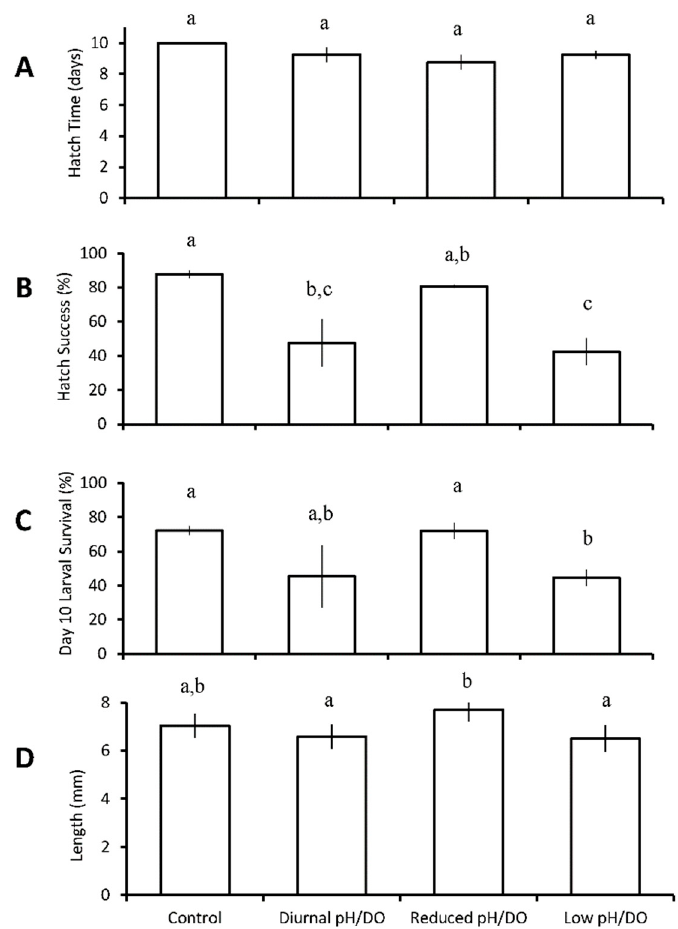
Figure 4. Hatch time ( A ), hatch success ( B ), survival ( C ), and length ( D ) of Menidia beryllina larvae